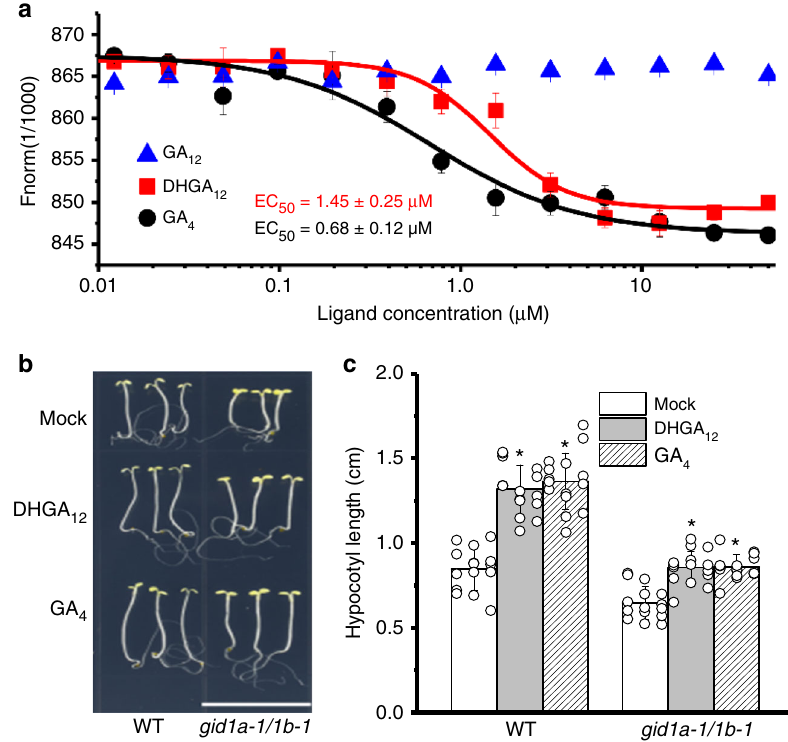
Fig. 6 DHGA 12 can directly bind to the GA receptor (GID1c). a Microscale thermophoresis (MST) analysis of DHGA 12 and GA4 binding to GID1c. Dissociation constants of DHGA 12 and GA 4 with GID1c are 1.45 ± 0.25 μ M and 0.68 ± 0.12 μ M, respectively. Error bars represent SD ( n = 3). b , c Effect of exogenous application of 5 μ M DHGA 12 and 5 μ M GA 4 on hypocotyl elongation of 10-d wild-type and gid1a-1/1b-1 seedlings grown under continuous far- red light illumination. Data represent means ± SD ( n = 15; t test; * P < 0.05). Bar = 1.5 cm. Source data are provided as a Source Data fi le. GA